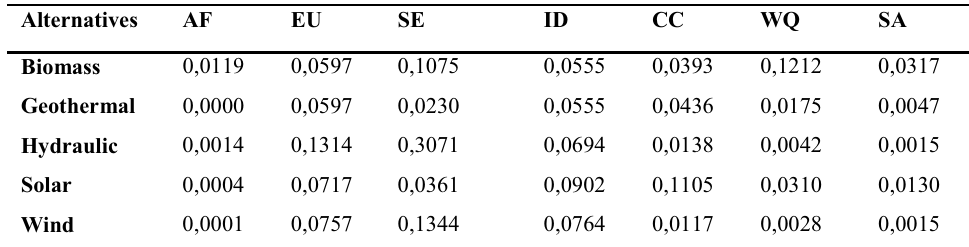
Table 7: Weighted normalized decision matrix